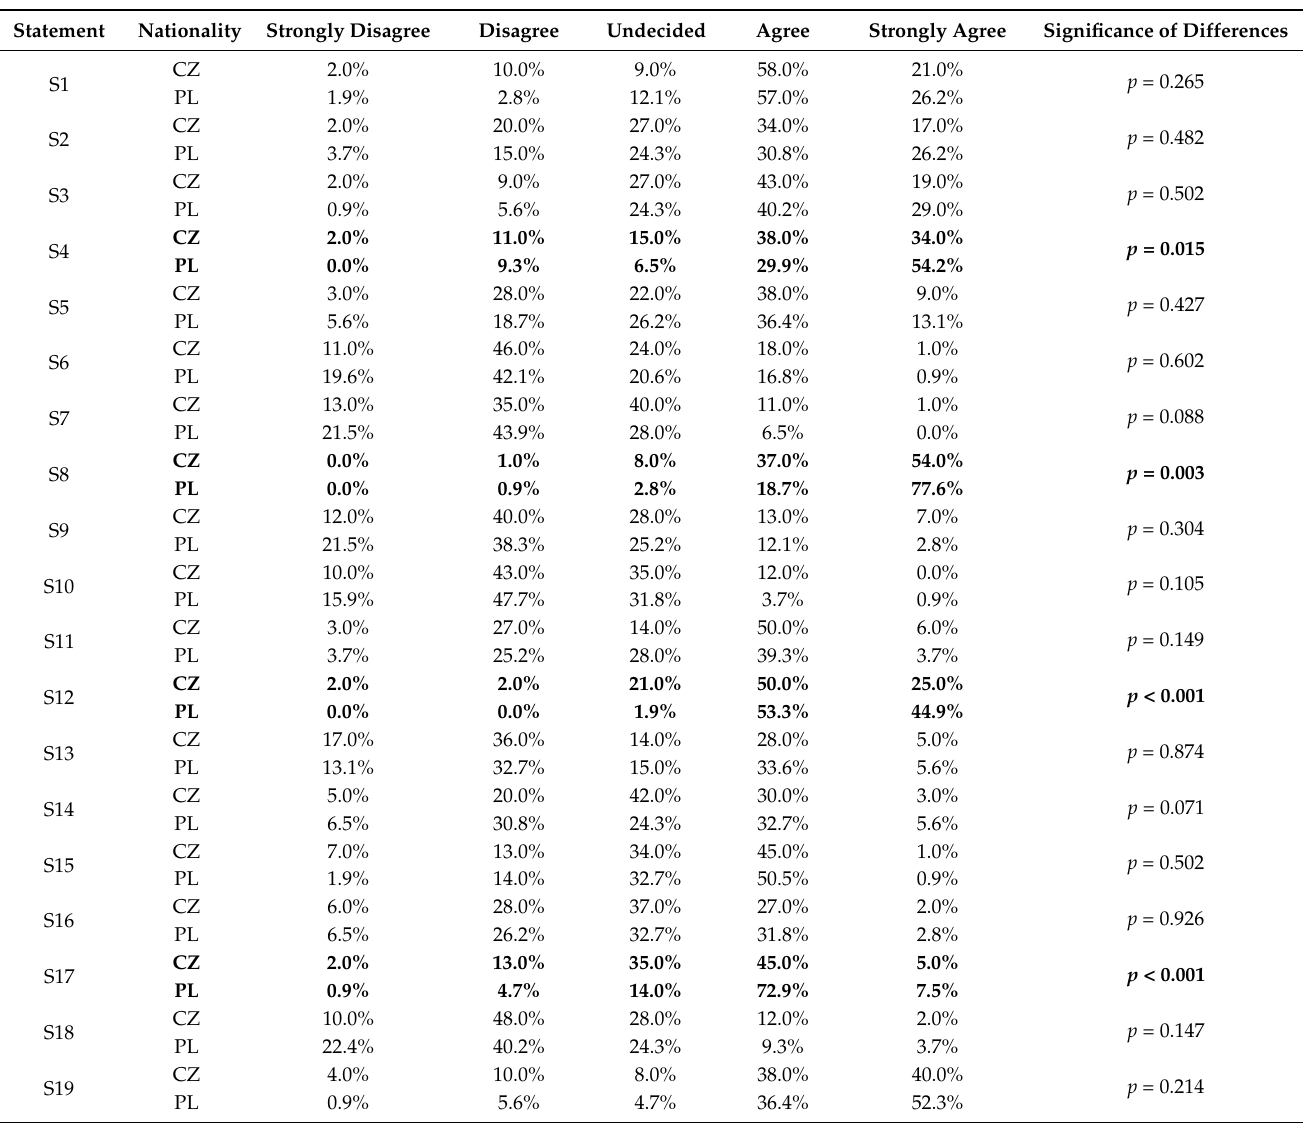
Table 4. Distribution of answers by nationality and significance of